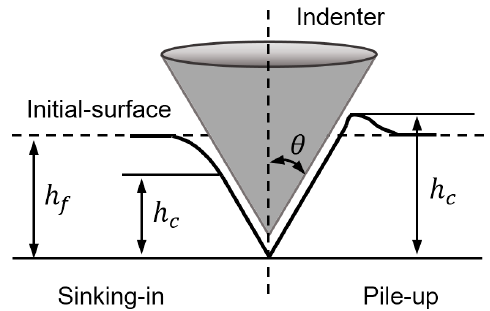
Figure 6. Schematic of the residual imprint in conical indentation.